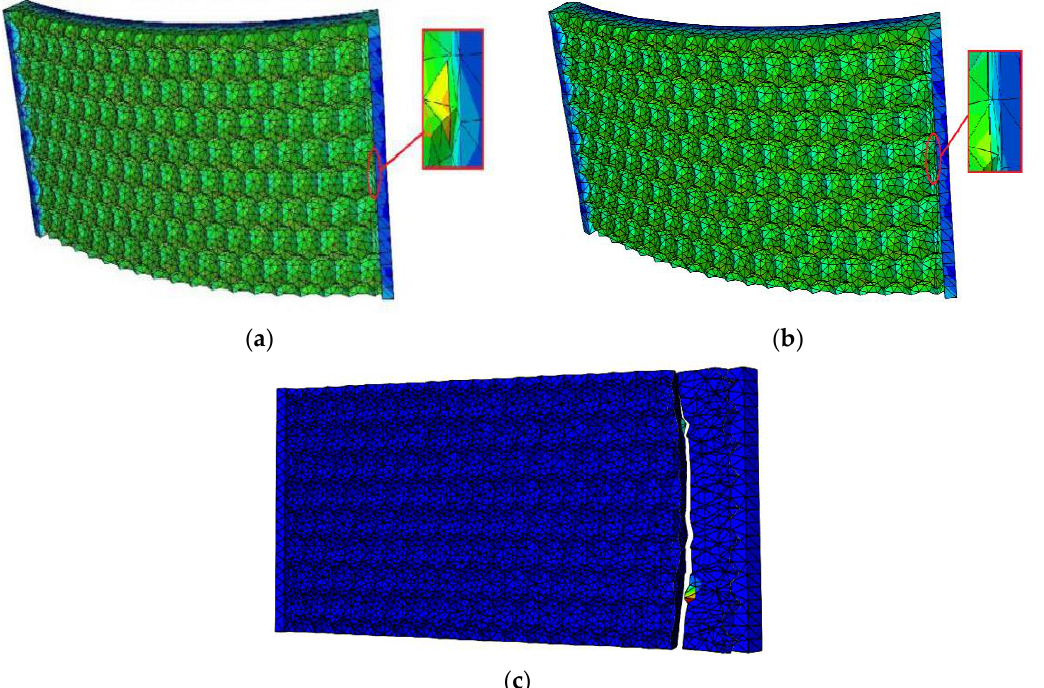
Figure 17. Graph of crack extension of hexagonal model: ( a ) Crack occurrence stage; ( b ) crack extension stage; ( c ) final breaking stage.